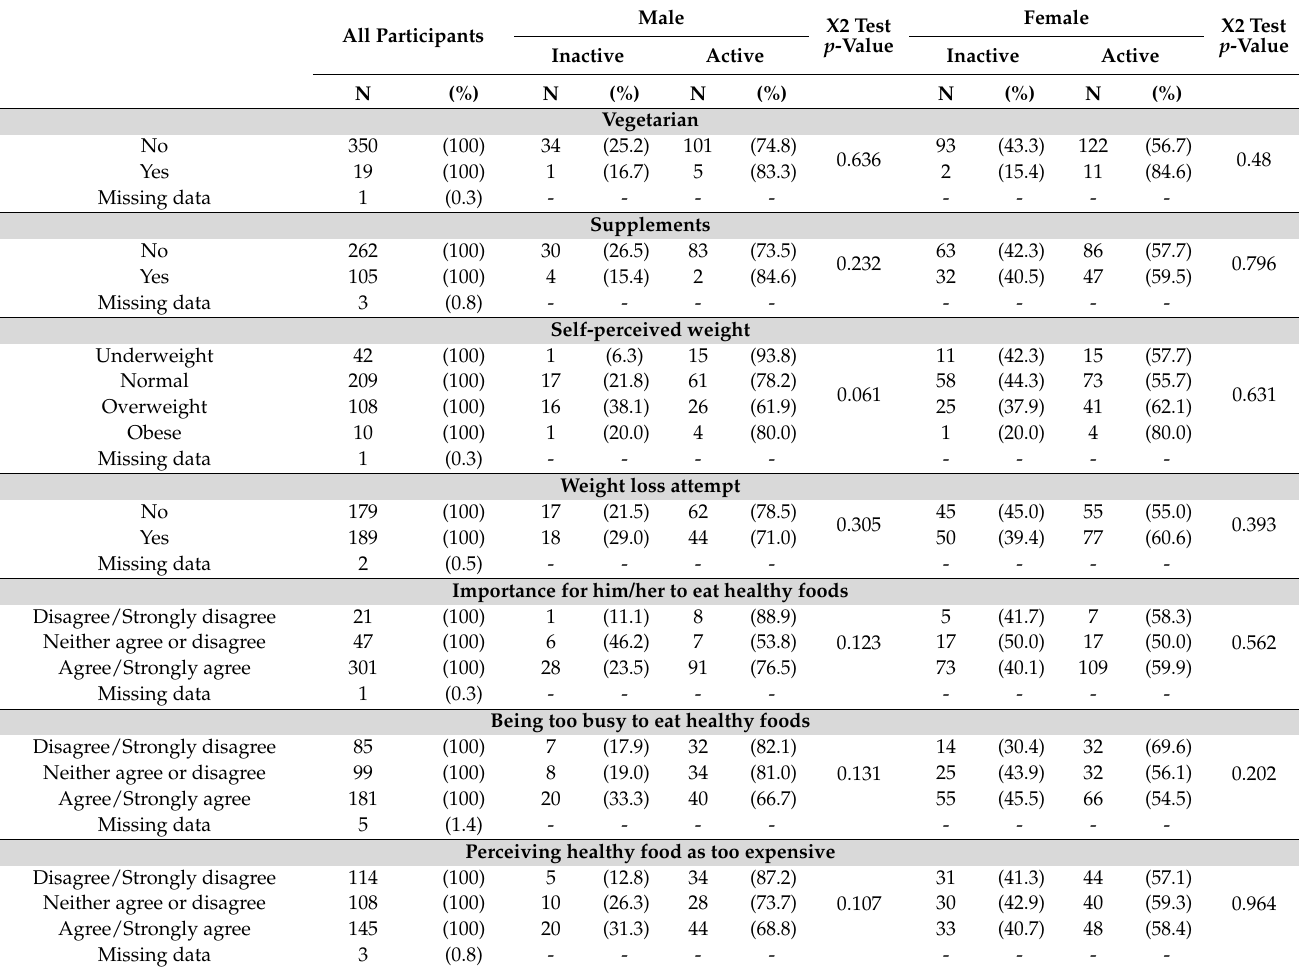
Table 5. Physical activity and dietary-related